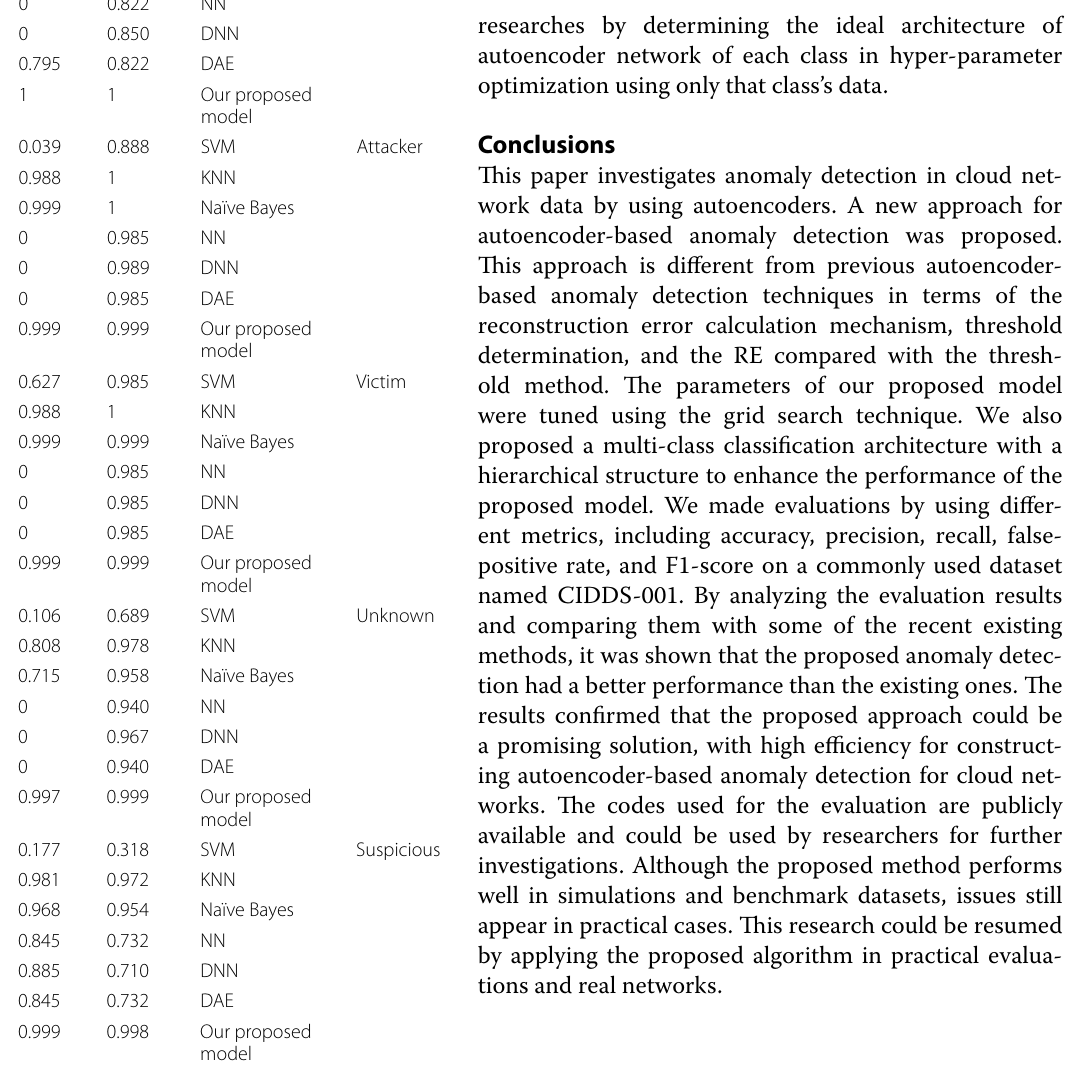
Table 4 Performance comparison of the proposed model with the method presented in [20] in terms of F1-score, Recall, Precision, FPR, and Accuracy